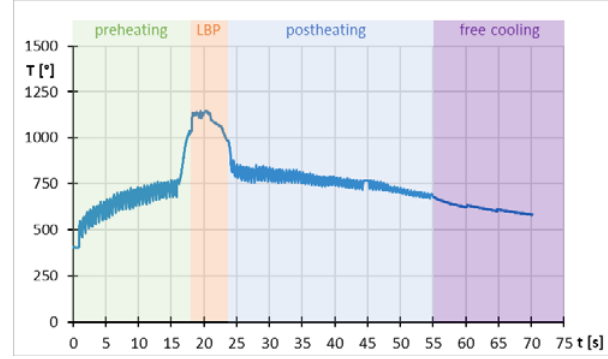
Fig. 3. Temperature-time curves for boroncrown glass (BK7)